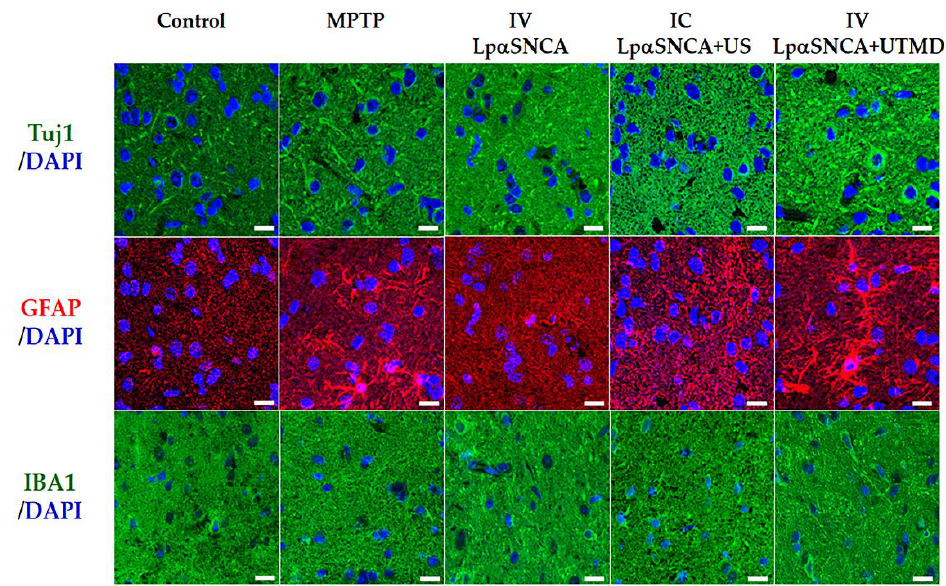
Figure 6. Pathological changes in the substantia nigra (SN) of different DA neuron-deficit PD models (MPTP, IC with Lp α SNCA (10 μ g pDNA), and IV with Lp α DNA (60 μ g pDNA) +/− UTMD). Images of fluorescence-labeled IHC SN-based staining (green: Tuj1 and IBA1 to identify neurons and microglia; red: GFAP to identify astroglia; blue: DAPI to mark cell nuclei). n ≥ 3 for each group MPTP = 1-methyl-4-phenyl-1,2,3,6-tetrahydropyridine; IC = intracerebral; IV = intravenous; US = focused ultrasound; UTMD = focused ultrasound-targeted microbubble destruction. Scale bars = 20 μ m.